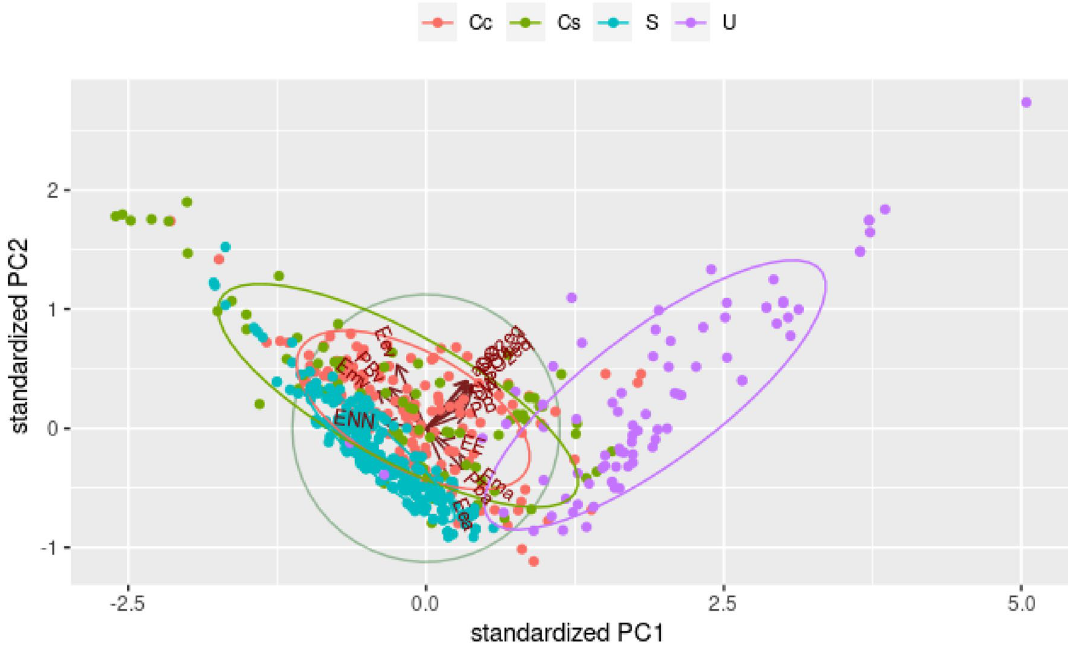
Figure 5. Biplot of standardized first (PC1) and second principal components (PC2) with observations of diets for dogs. Cc homemade diets, Cs website homemade diets, S dry diets, U wet diets, ENN nitrogen-free extract, PBv protein from vegetable sources, Emv metabolizable energy from vegetable sources, Eev fat from vegetable sources, CO2eq carbon dioxide equivalent, area land use, PO4eq phosphate equivalent, SW stress-weighted water usage, SO2eq sulphur oxide equivalent, UA freshwater withdrawals, PB protein content, EE fat content, Ema metabolizable energy from animal sources, Pba protein from animal sources, Eea fat from animal